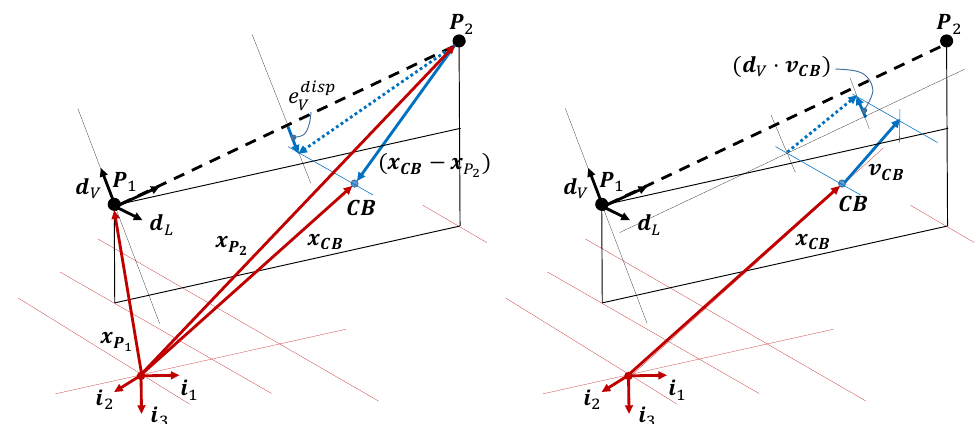
Figure 5. Sketch of beam-tracking measurements in the longitudinal plane. ( Left ) definition of e disp ( Right ) computation of d V · v CB